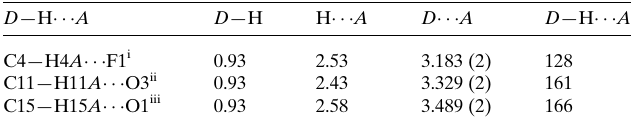
Table 1 Hydrogen-bond geometry (A˚ , (cid:4) ).